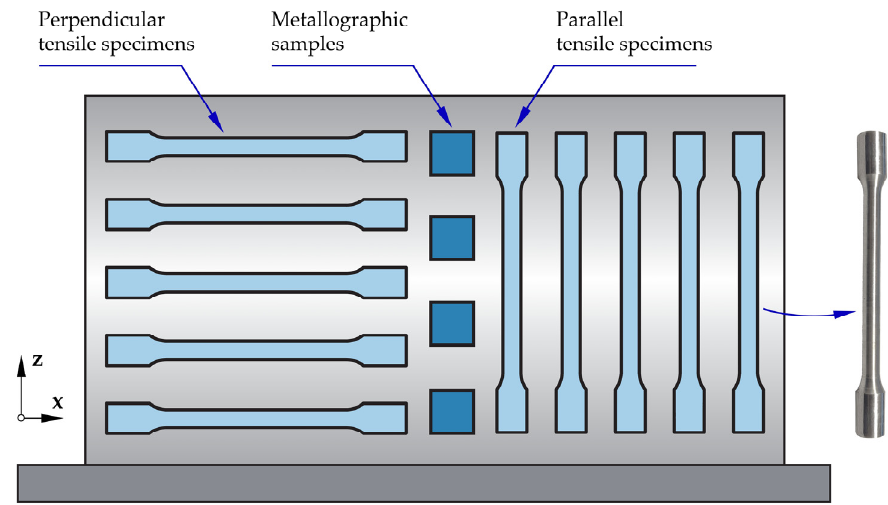
Figure 2. Schematic representation of the tensile test specimens extracted from the deposited ER5356 aluminum straight walls.